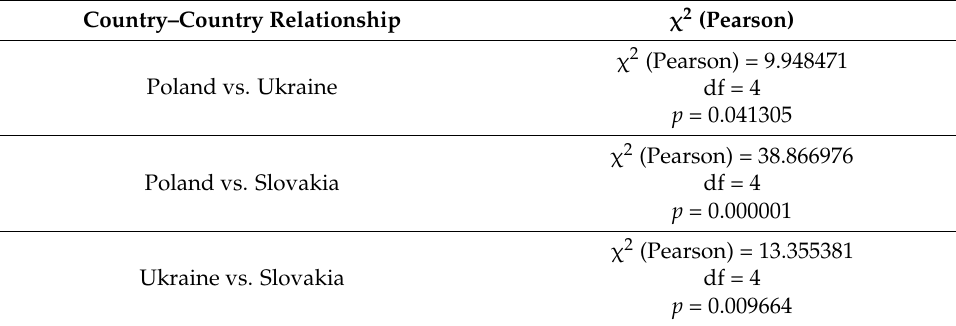
Table 3. Results of χ 2 test for the relationship between the studied countries in the area of global problems related to environmental degradation.